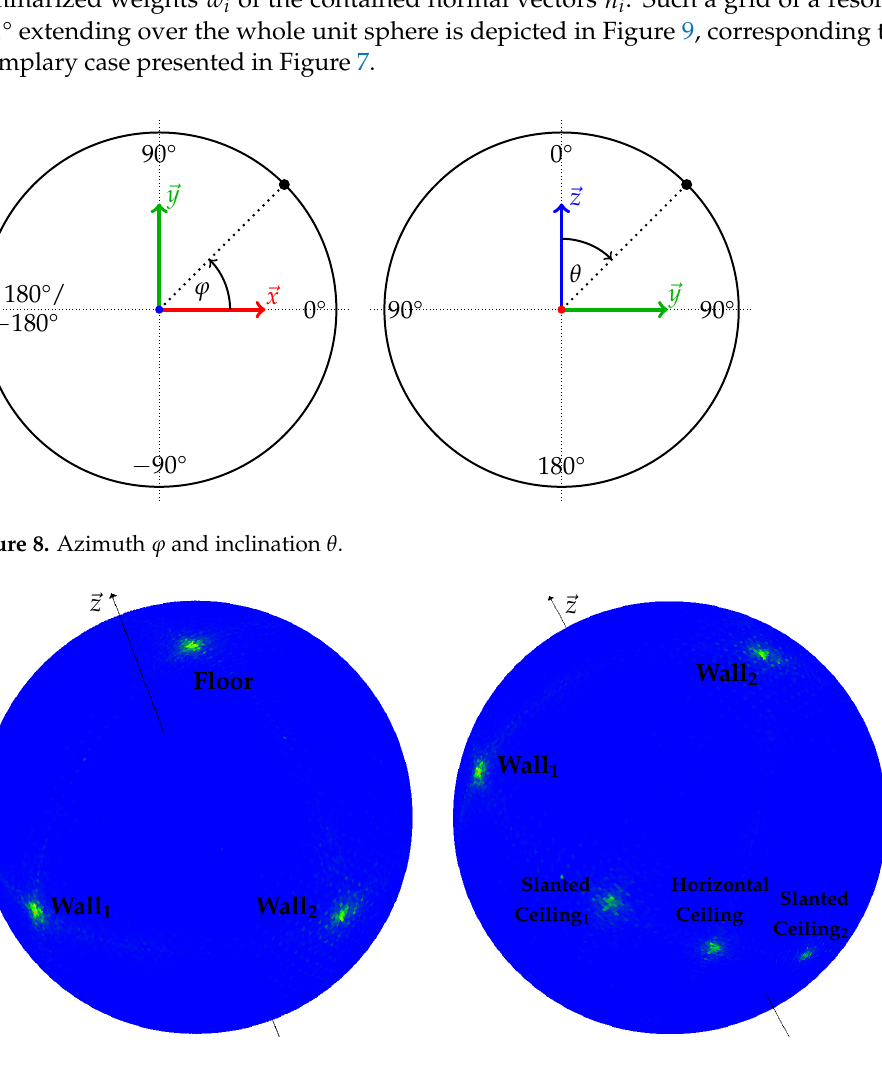
Figure 9. Azimuth/inclination grid of a 1° resolution over the whole surface of the unit sphere corresponding to Figure 7. The grid cells contain the summarized weights w i of the contained normal vectors (cid:126) n i at polar angles ( ϕ i , θ i ) with value colorization ranging from blue for low values over green and yellow to red for large